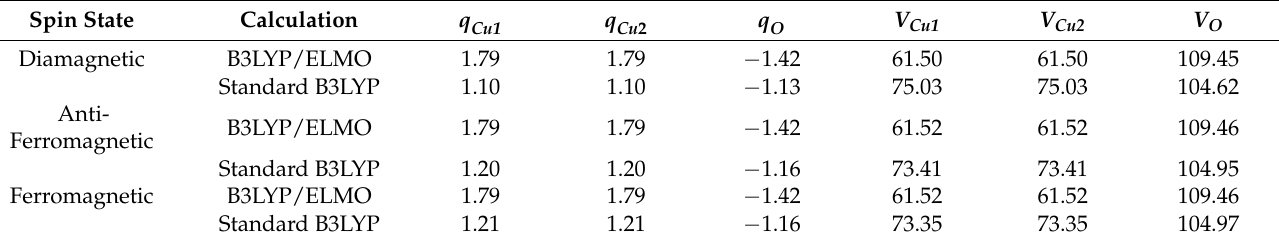
Table 2. Bader charges and volumes (0.001 e/bohr 3 isosurface) for the Cu and O atoms, as obtained from calculations performed at different levels of theory with basis set 6-311G(2d,2p) on the model system extracted from the HKUST-1 experimental crystal structure with a water chemisorption degree of 14.3(6)%. (a) Spin